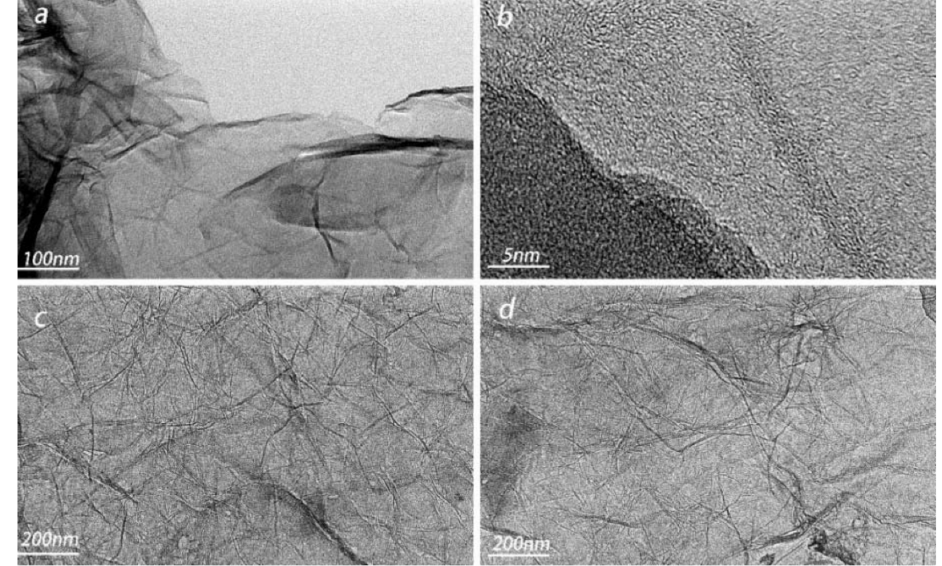
Figure 2. TEM images of ( a , b ) GA aerogel and ( c , d ) GA-MCC-4 aerogel.